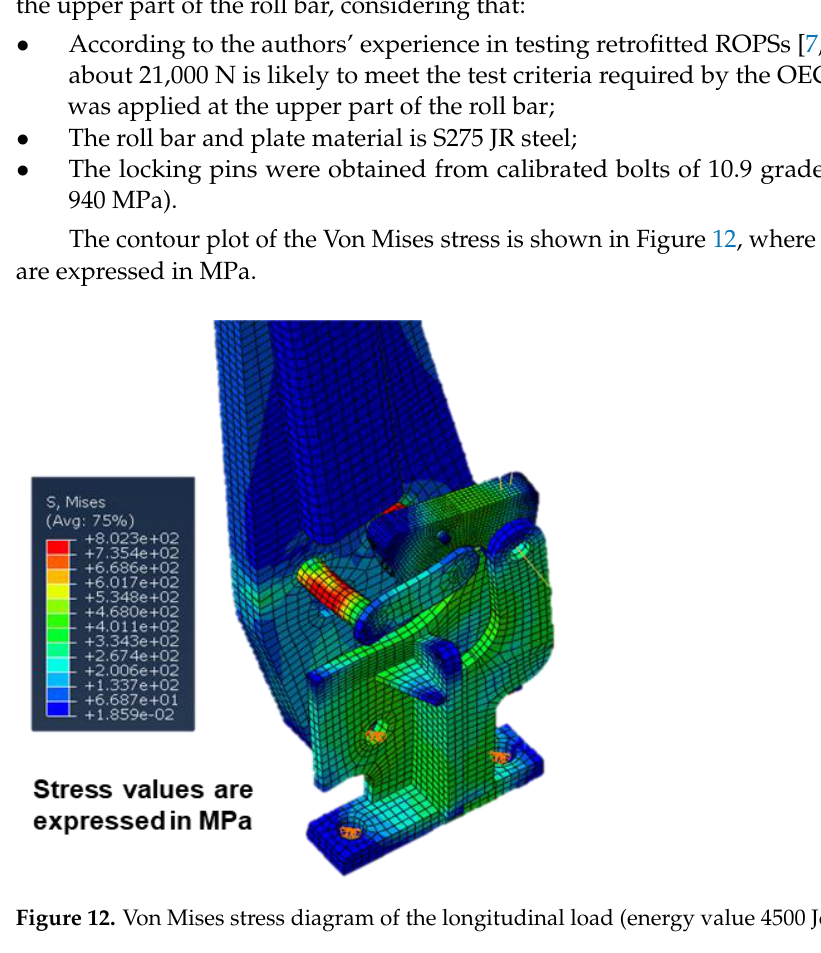
Figure 12. Von Mises stress diagram of the longitudinal load (energy value 4500 Joules).